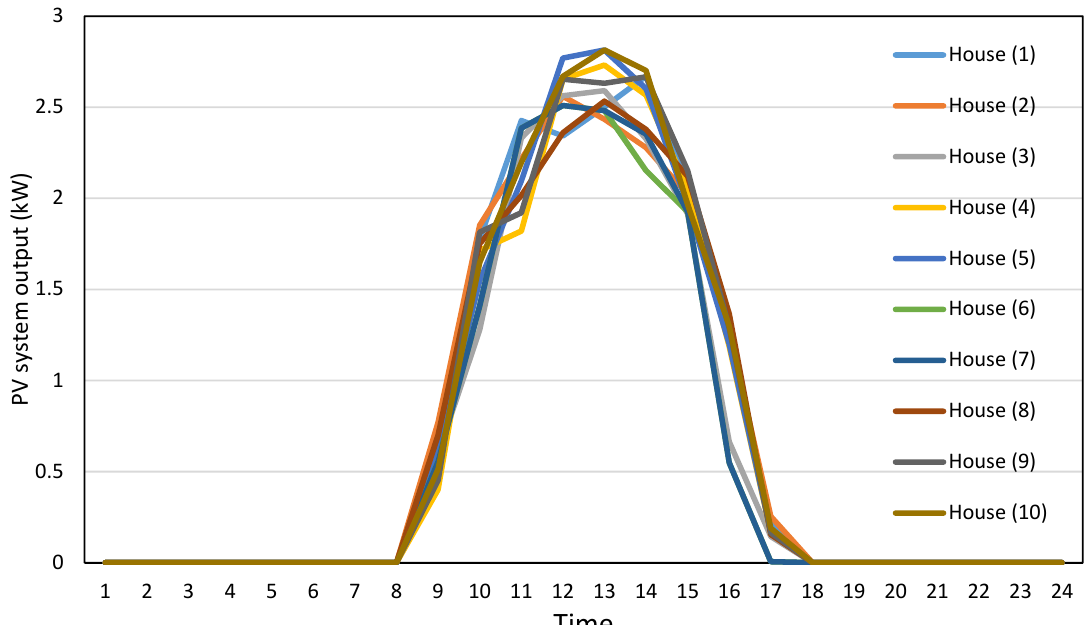
Figure 4. The ten household PV system output curves for a typical sunny day (22 August 2019).